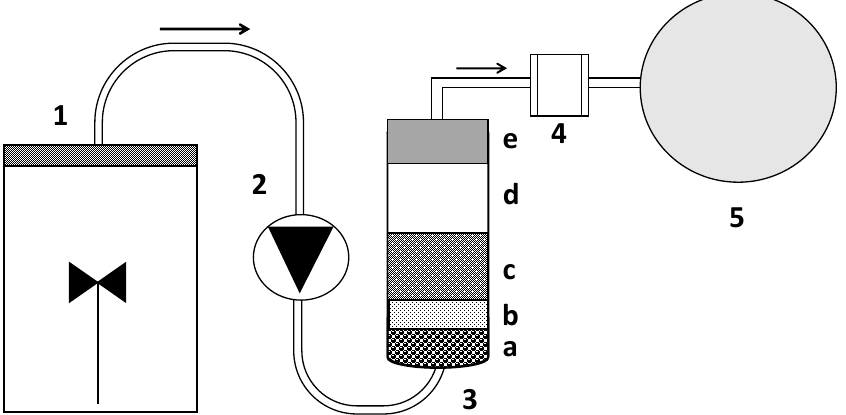
Figure 2. Scheme of the research station: (1) anaerobic reactor producing biogas; (2) peristaltic pump; (3) fixed-bed column for biogas upgrading; (a) support layer; (b) glass wool; (c) bio-waste sorbent; (d) gas phase; (e) tight cover with discharge valve; (4) gas flow meter; (5) gas bag for storing upgraded biogas.